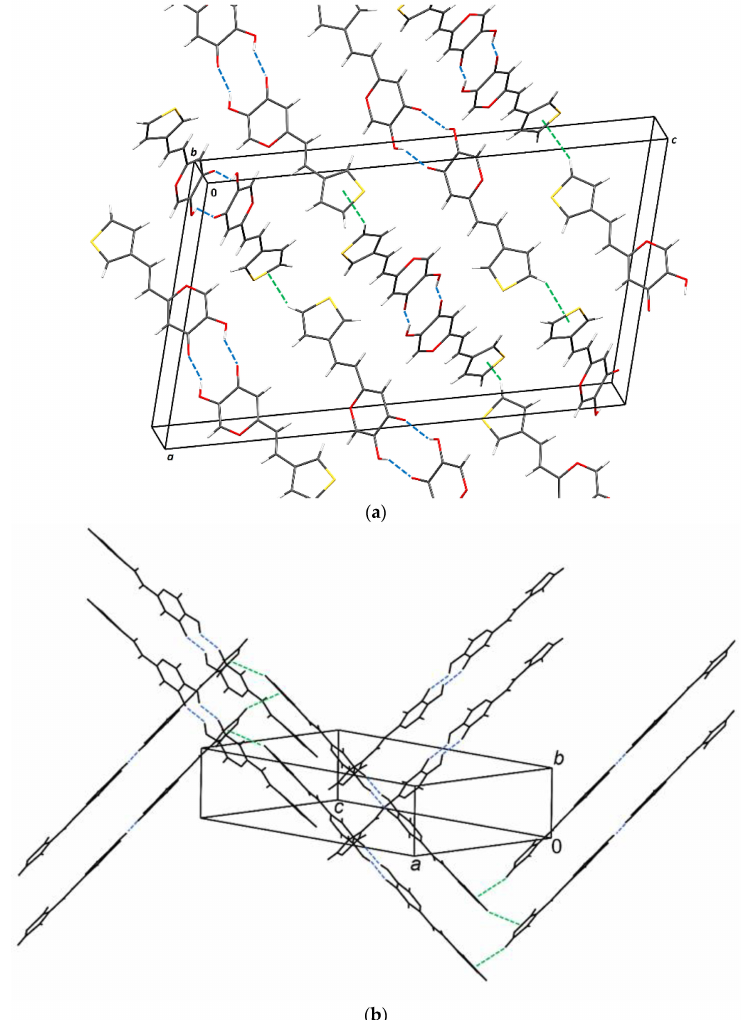
Figure 16. Crystal packing of trans - 6 : ( a ) layers generated by hydrogen bonds (O–H · · · O) and C–H · · · π interactions; ( b ) zig-zag chains in the direction